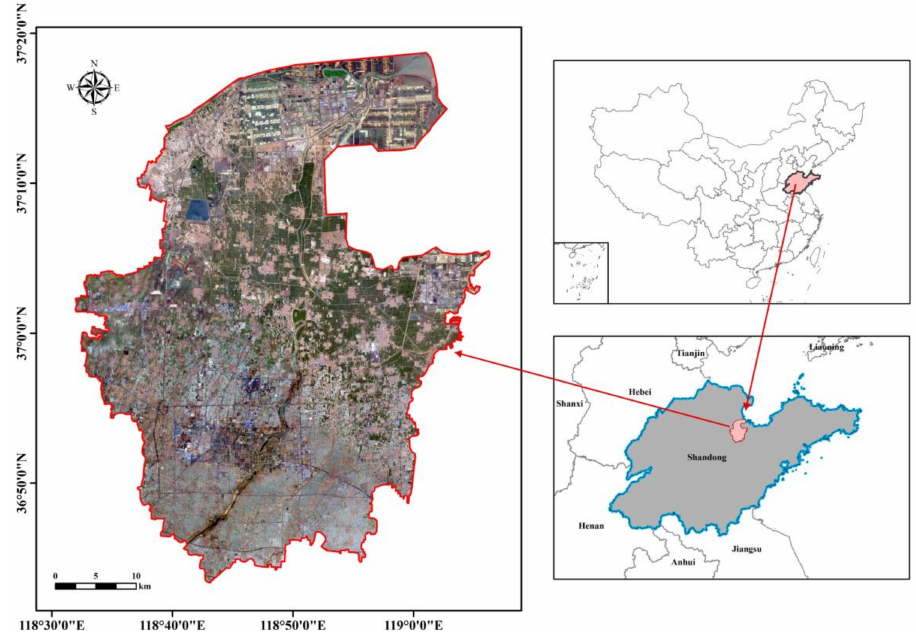
Figure 1. The location of the study area. Coordinate system: WGS_1984_UTM_Zone_50N.